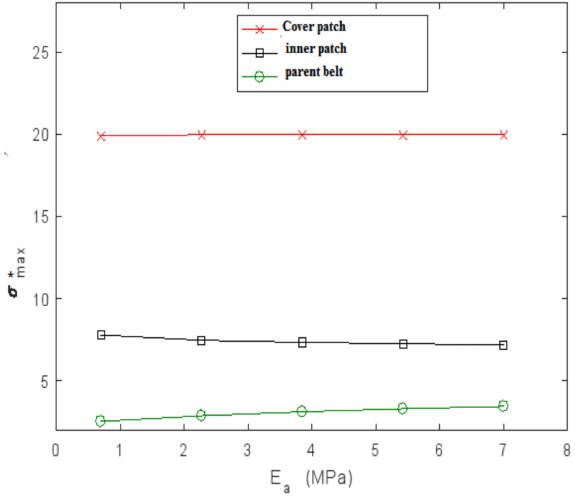
Figure 15. Variation of the maximal normalized normal stress ratio σ ∗ max in adherents as a function of adhesive Young’s modulus E a .